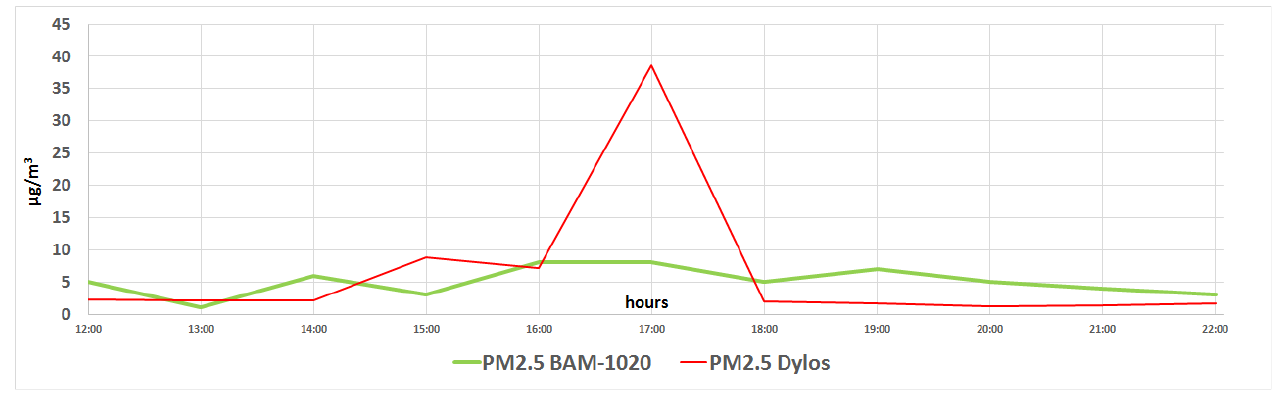
Figure 2. Real-time graph of OPC operating in an ECSHA environment generated by the EC (brand Elips C).